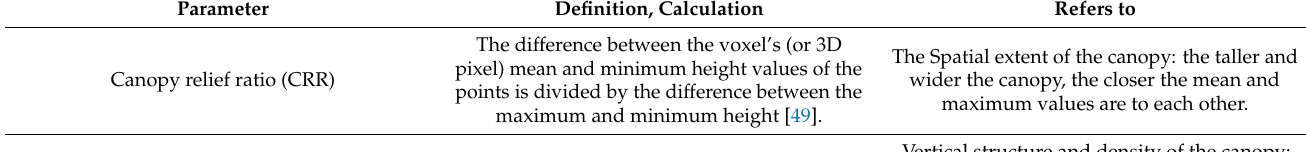
Table 1. Definition and main characteristics of statistical parameters used to identify various riparian vegetation types. Parameter Definition, Calculation Refers to The difference between the voxel’s (or 3D pixel) mean and minimum height values of the Canopy relief ratio (CRR) points is divided by the difference between the maximum and minimum height